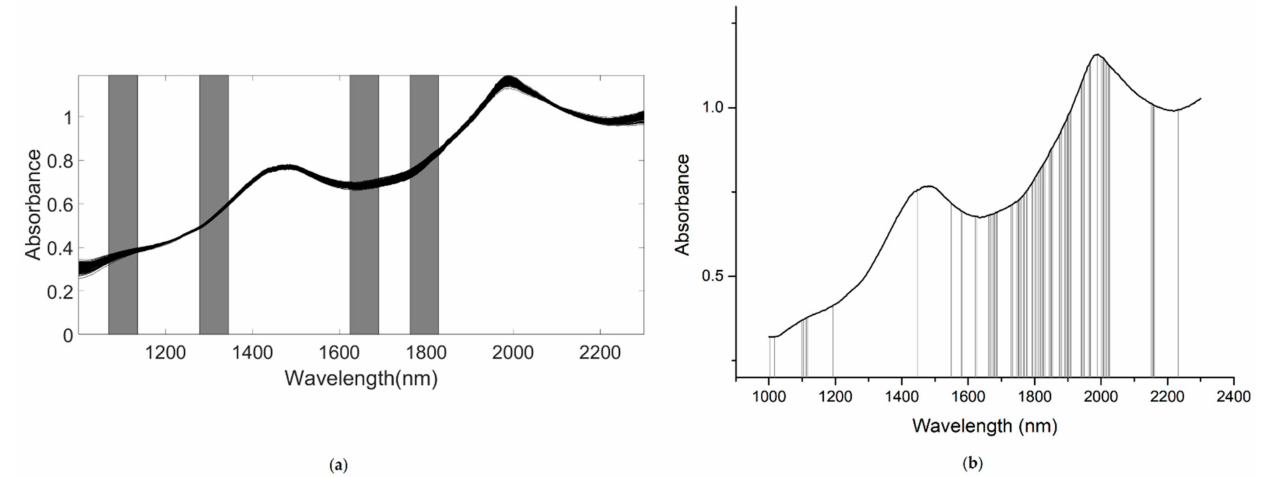
Figure 11. The useful variables selected by the ( a ) SiPLS and ( b ) GA for measuring TA.